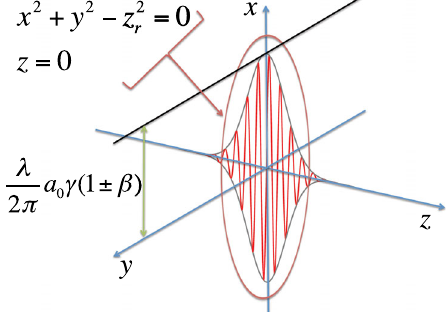
FIG. 8. Diagram showing the location of the singularity in the vector beam model in relation to the particle orbit.